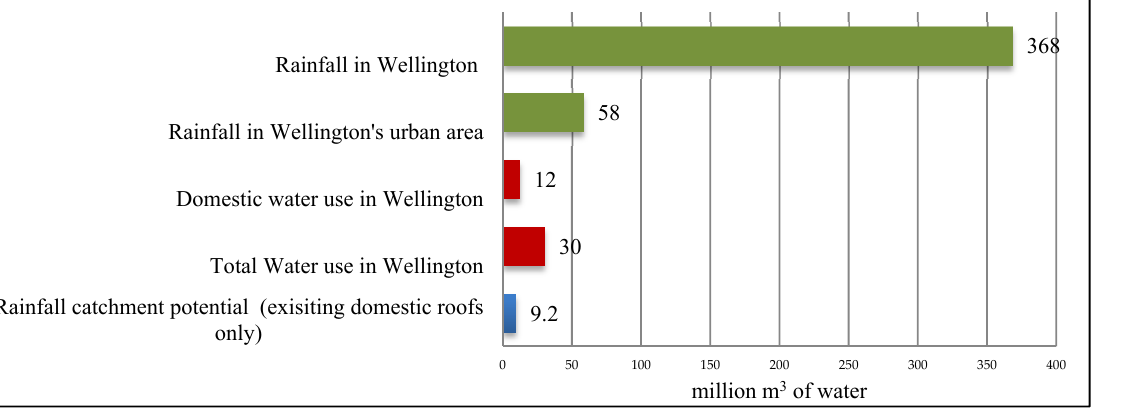
Figure 2. Water in Wellington.